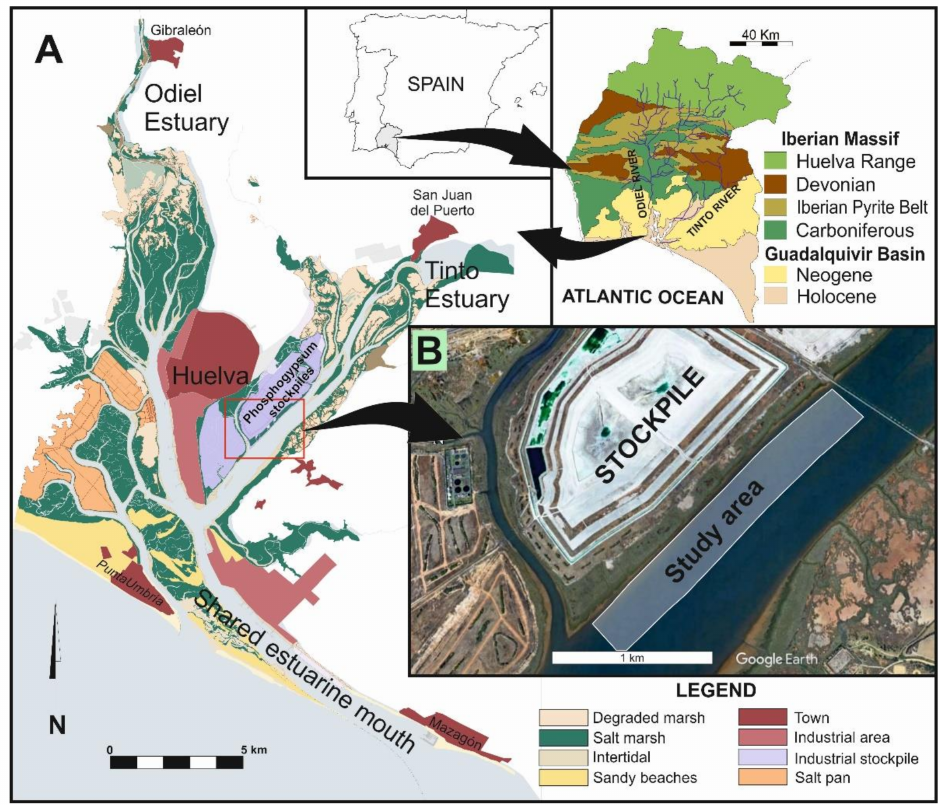
Figure 1. Location of the study area. ( A ) Ria de Huelva, where estuaries of Odiel and Tinto rivers link in a shared mouth. ( B ) Study area on the Tinto estuarine channel along the margins of a phosphogypsum